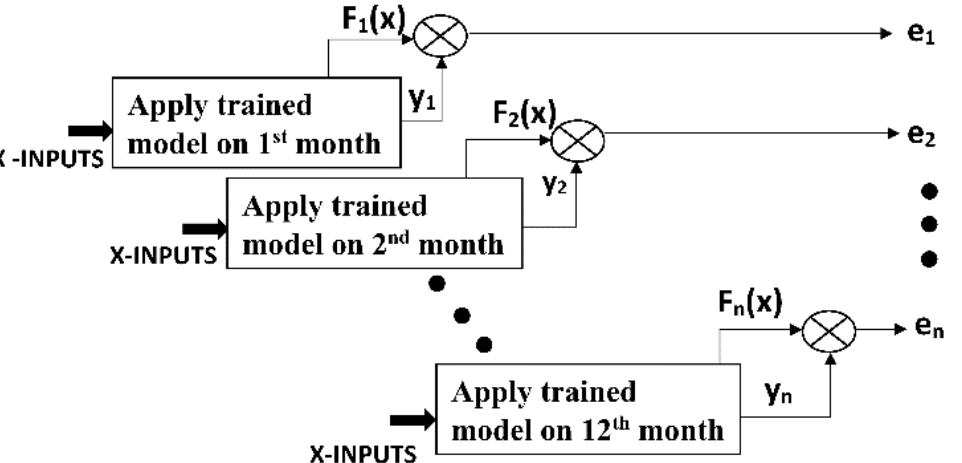
Figure 12. ML with temporal error extraction method. Six different pdf parameters are used as inputs, and the two Lognormal pdf parameters are targets, as presented in Table 2.